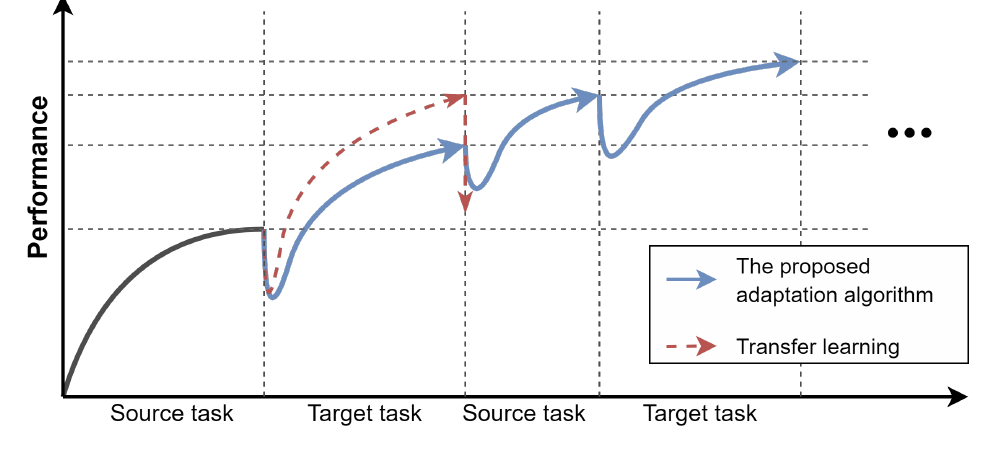
Figure 3. An illustration of the performance of an agent on the source and target tasks over adaptation